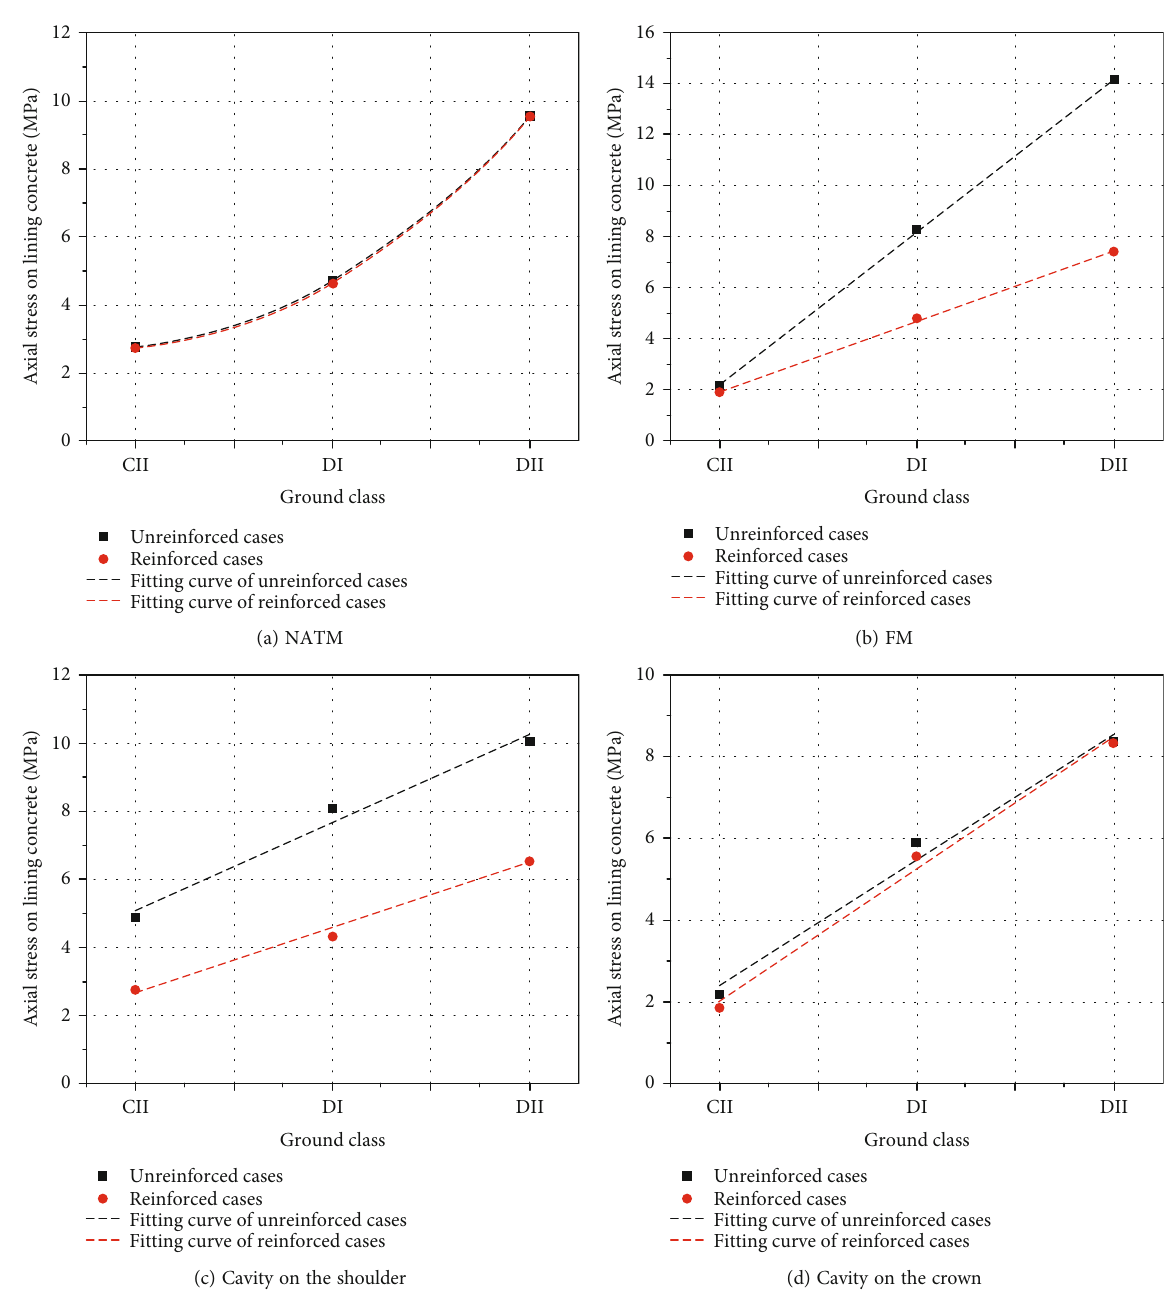
Figure 15: The variation of maximum axial stress on lining